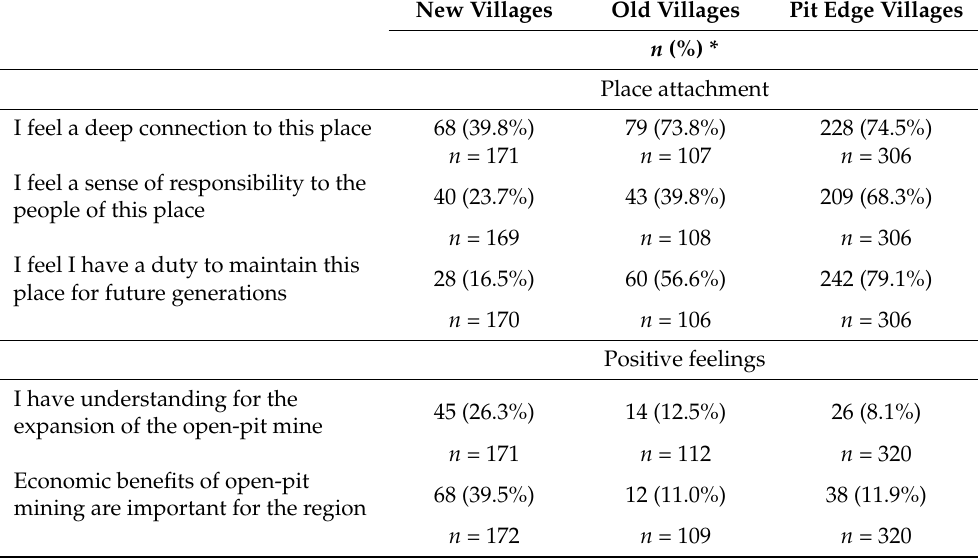
Table 3. Place Attachment and Feelings about Changes caused by Open-Pit Mining.